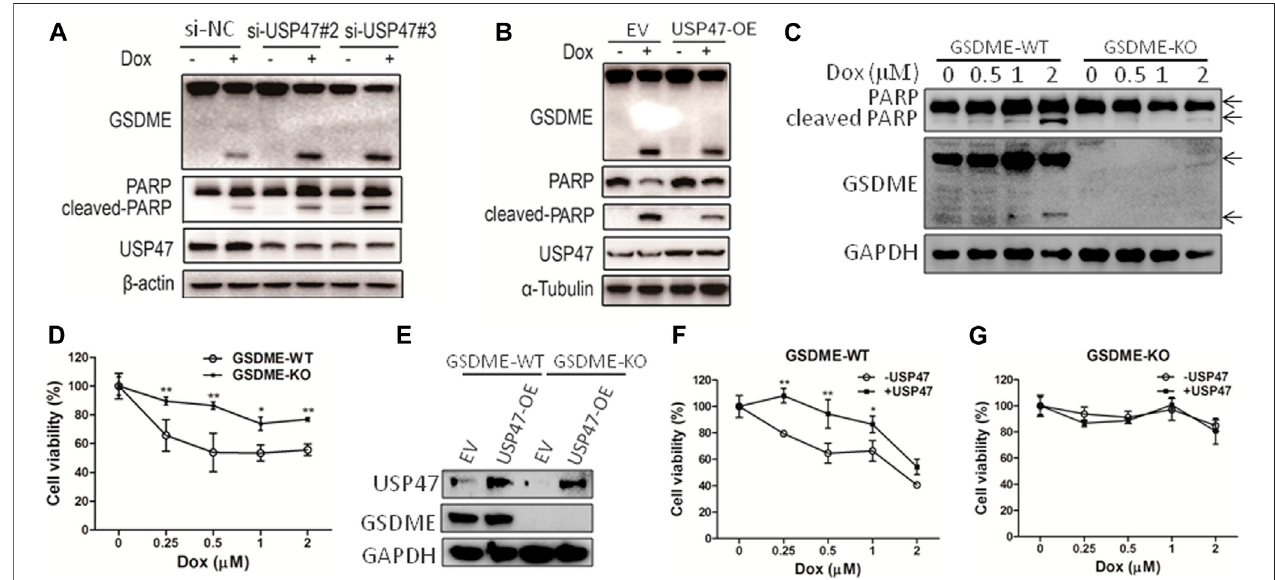
FIGURE 2 | USP47 regulates the cell death of CRC cells induced by doxorubicin. (A) Immunoblotting of GSDME, PARP and USP47 in HCT116 cells transfected with siRNAs for USP47 and treated with 1 μ M Dox, doxorubicin. (B) Immunoblotting of GSDME, PARP and USP47 in HCT116 cells overexpressing USP47 and treated with1 μ M. (C,D) Thewild-type(GSDME-WT)andGSDME-knockout(GSDME-KO)HCT116cellswereincubatedwithindicatedDoxovernight,andcellswereprepared for immunoblotting (C) and CCK-8 assay (D) . * p < 0.05, ** p < 0.01. (E) The overexpressing ef fi cacy of USP47. (F, G) GSDME-WT (F) or GSDME-KO (G) HCT116 cells were transfected with empty vector or USP47-overexpressing plasmids for 24 h, and then transfected cells were incubated with indicated Dox overnight, followed by CCK-8 assay. * p < 0.05, ** p < 0.01.